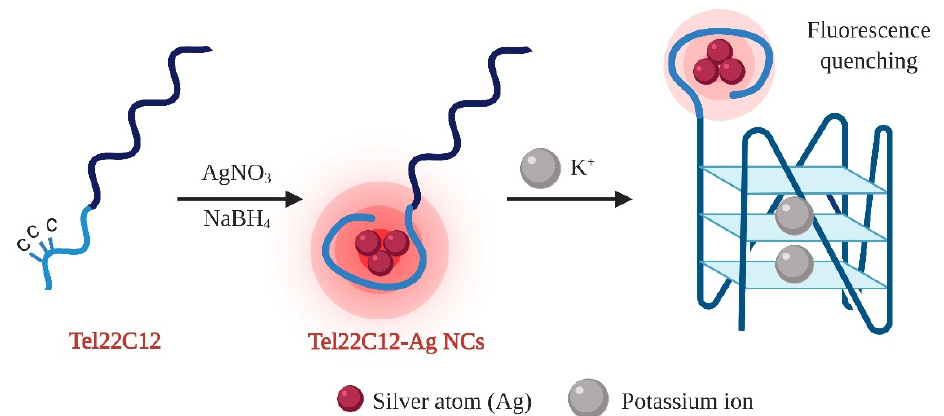
Figure 1. The demonstrative illustration shows the working idea of Tel22C12-AgNCs as potassium